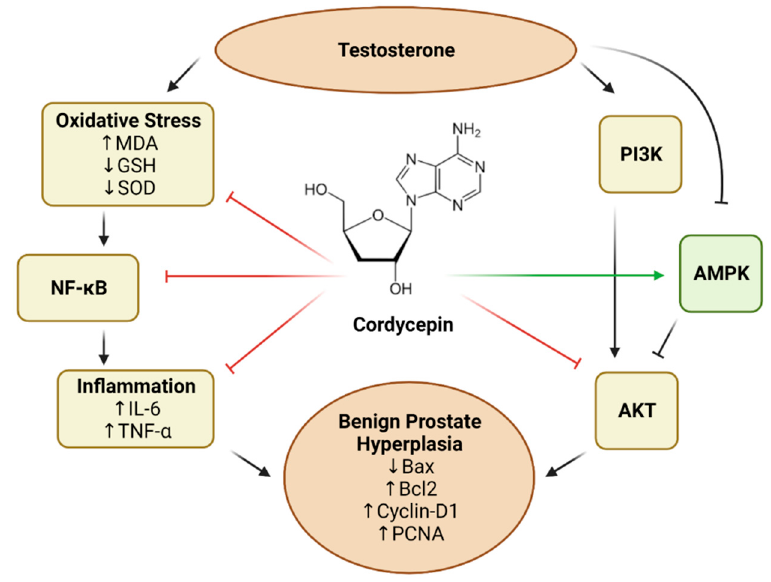
Figure 6. Graphical representation of the proposed mechanism of protection offered by cordycepin against BPH induced by testosterone. Blunt-head arrows indicate inhibition, whereas pointed-head arrows reflect stimulation.